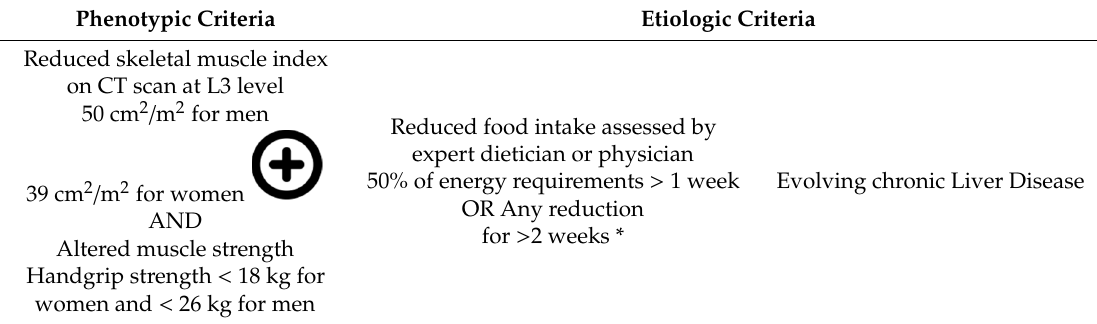
Table 3. 2018 definition and grading of malnutrition adapted for chronic liver disease [12].